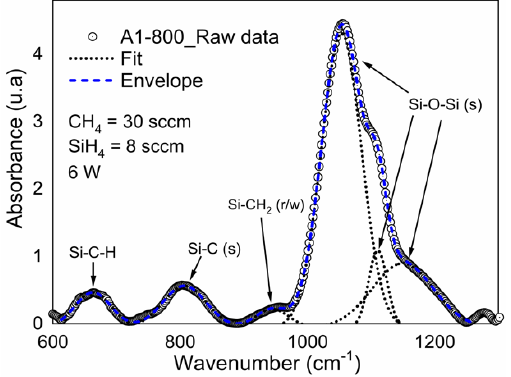
Figure 4. Deconvolution of A1 sample (6 W and R 0 = 37.5) upon fast annealing process at 800